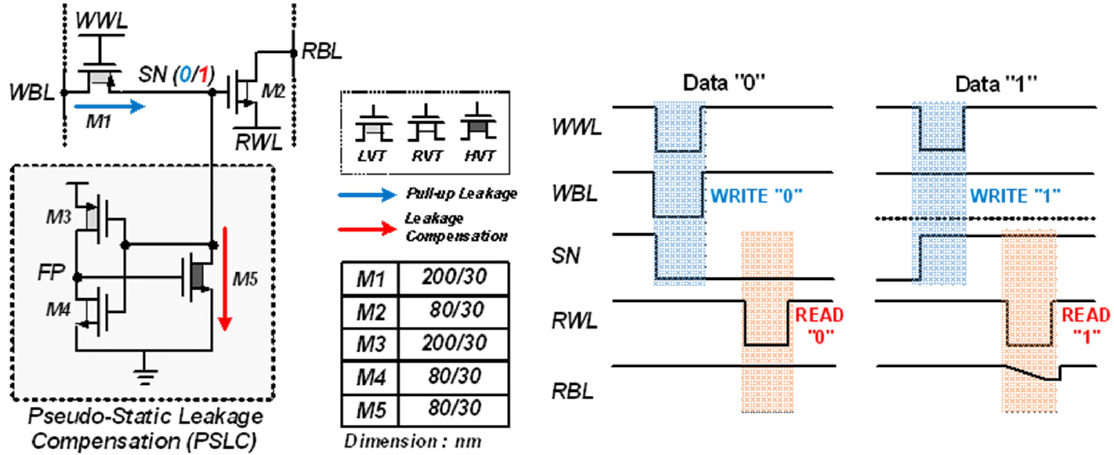
Figure 6. Schematic and conceptual timing diagram of proposed PS-GC.